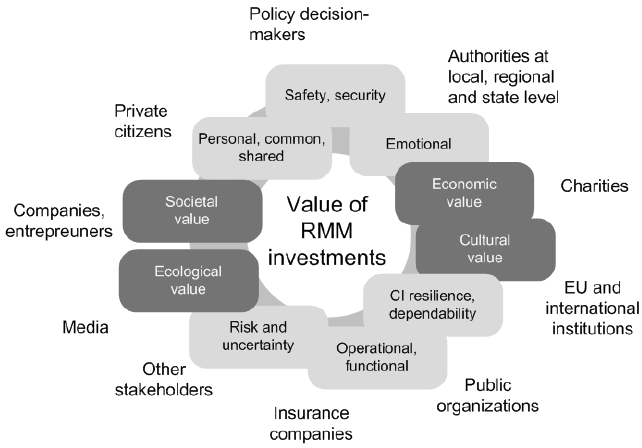
Figure 2. The value aspects of risk mitigation measures.